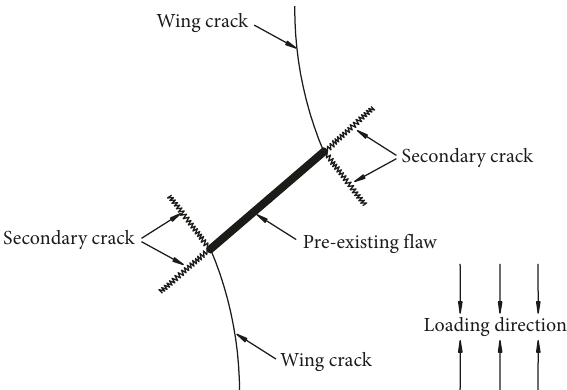
Figure 2: Simplified crack patterns in pre-cracked specimens of rock-like materials under uniaxial compression